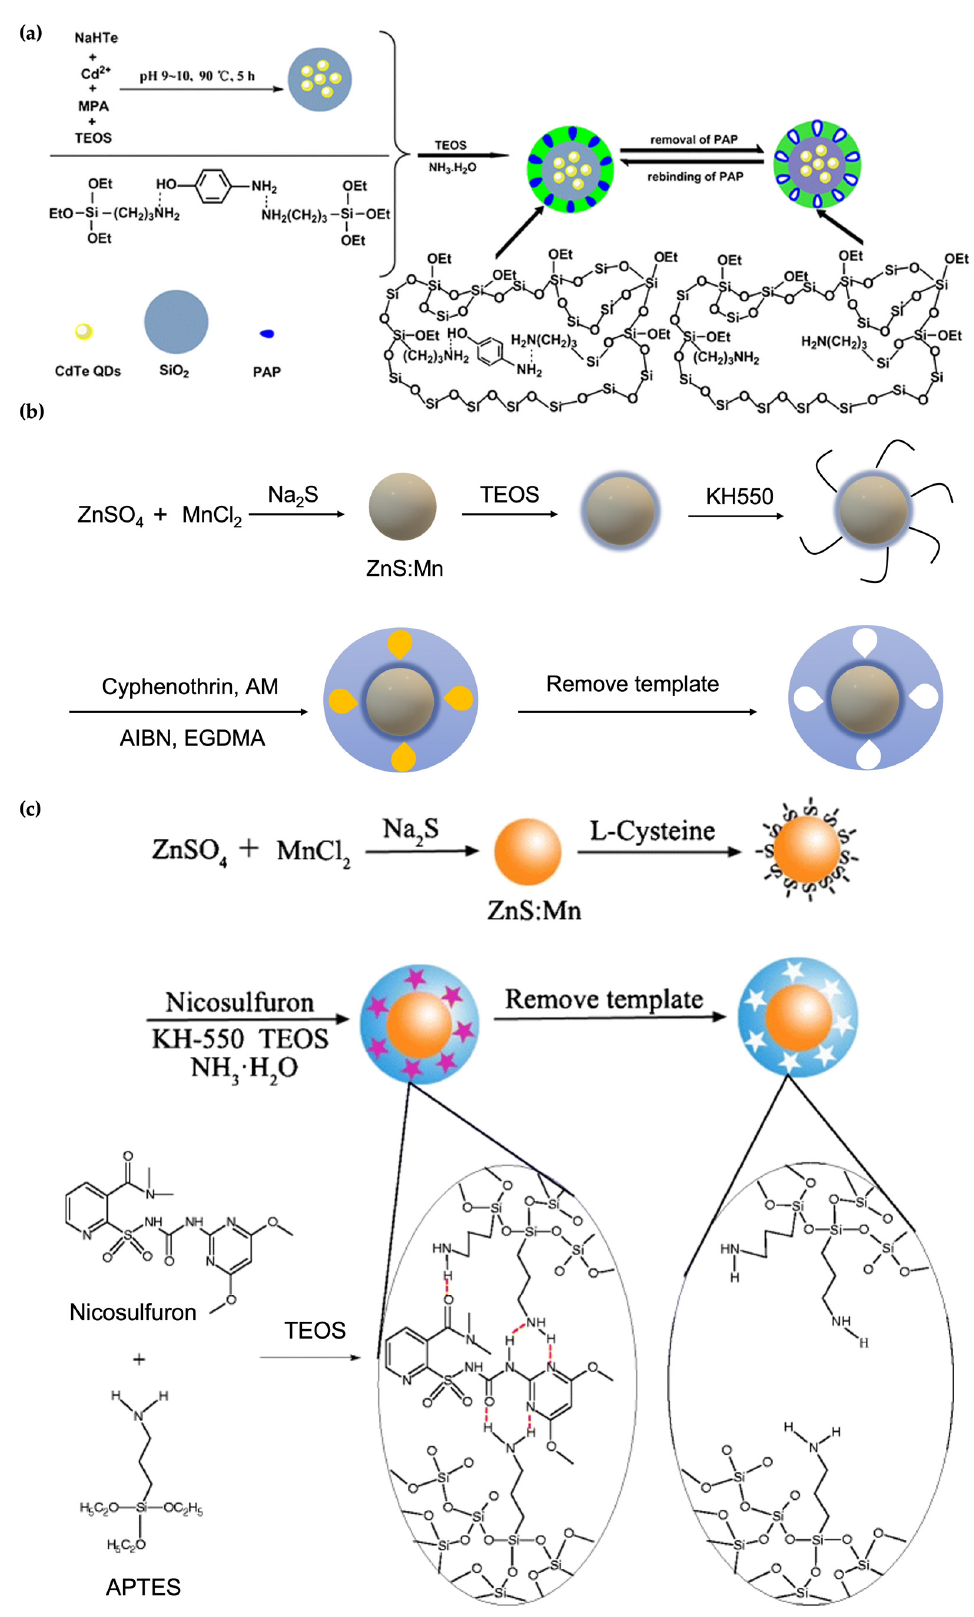
Figure 6. Demonstration of different strategies for preparing MIP@QDs. ( a ) Silica coating onto QDs, ( b ) inorganic–organic MIP@QDs, and ( c ) organic MIP@QDs. Reproduced with permission from [66,68,69] respectively.